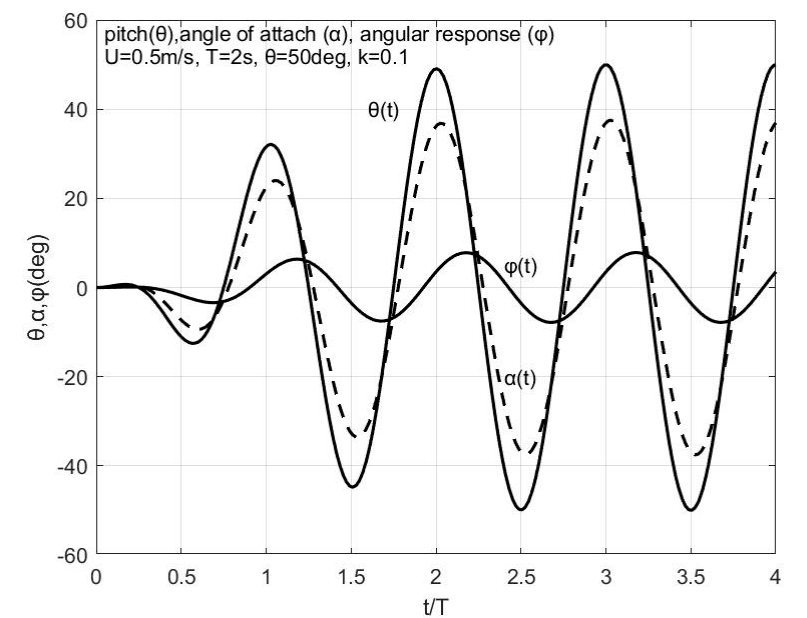
Figure 4. Time history of the prescribed self-pitching angle, the effective angle of attack and the angular response of the system as calculated by the present method, for the experimental configu- ration studied by Huxham et al. [7], for U = 0.5 m/s, reduced frequency k = 0.1, pitching amplitude θ 0 = 50 ◦ and dimensionless damping coefficient C (cid:48) =